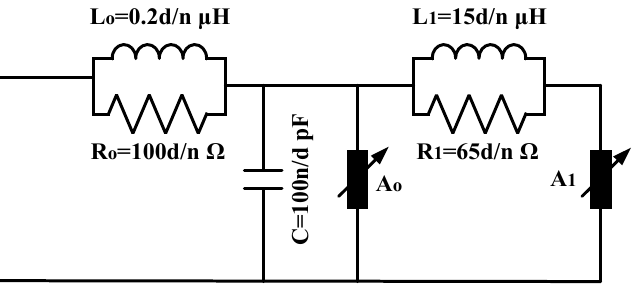
Figure 3. The IEEE model [8] (d is the height of the arrester in m, n is the number of varistor columns).